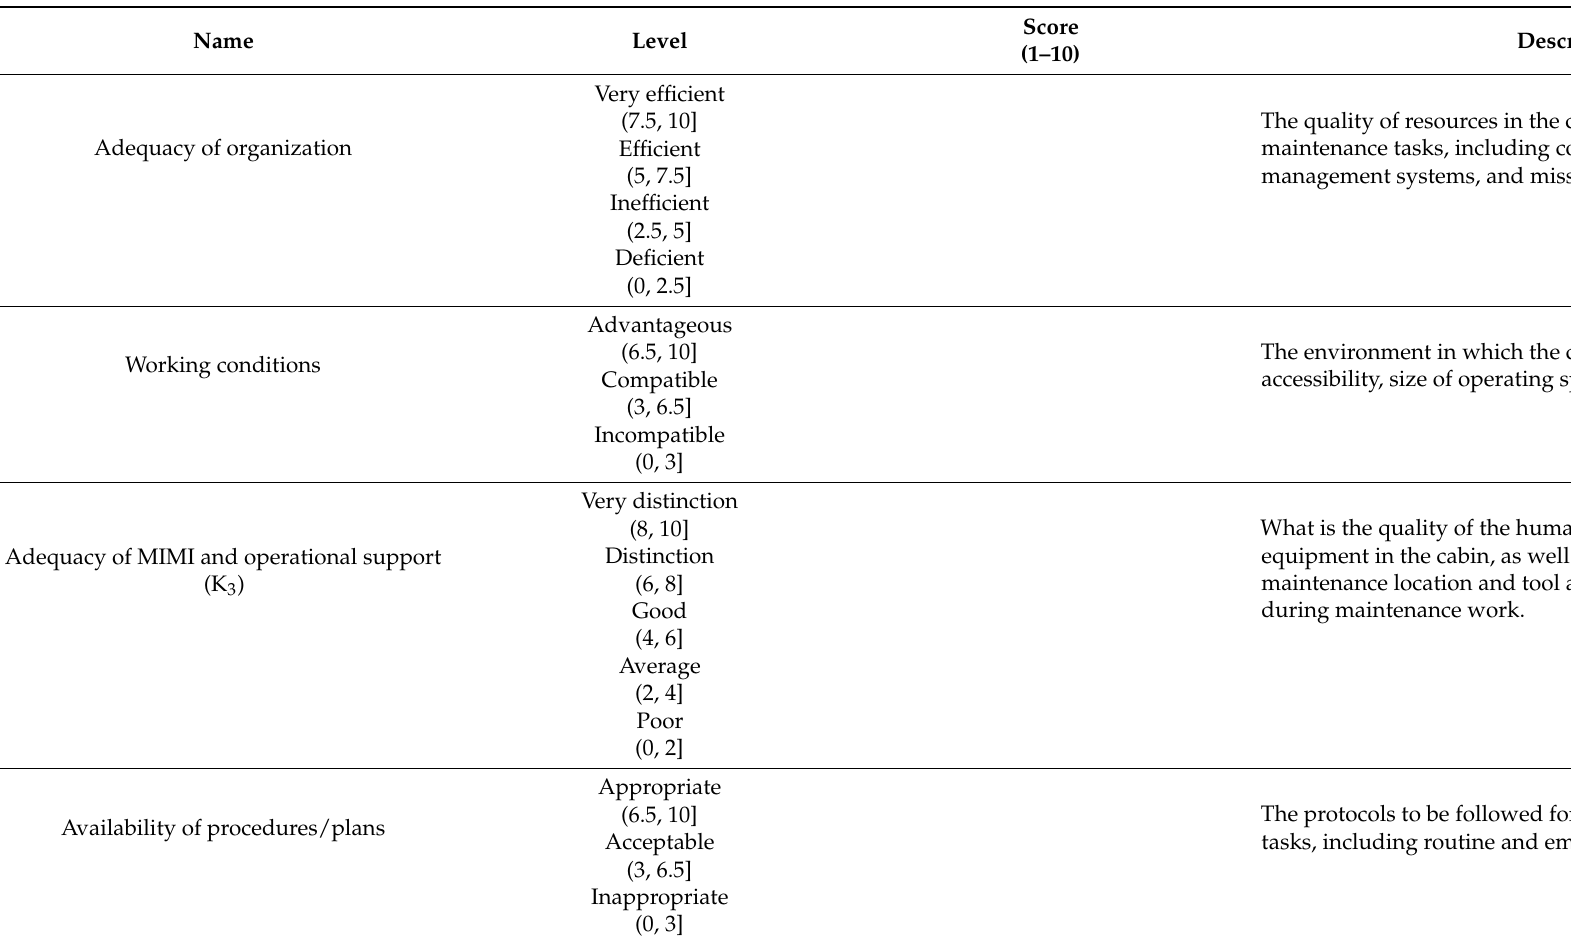
Table A1. The Evaluation of Cabin Environmental